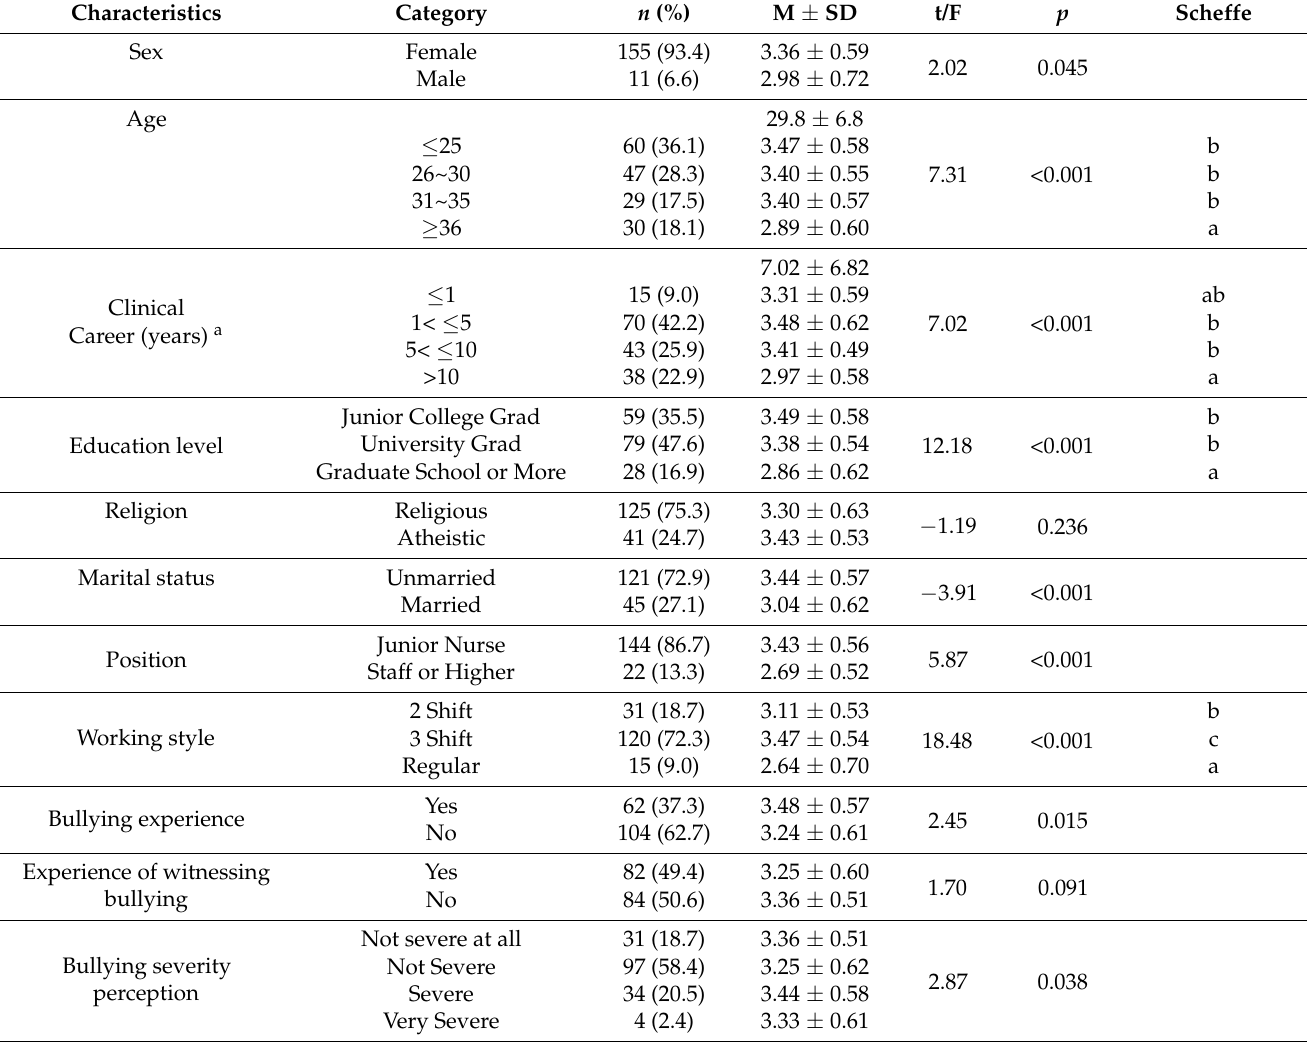
Table 1. Demographic characteristics according to the burnout of participants ( n = 166).